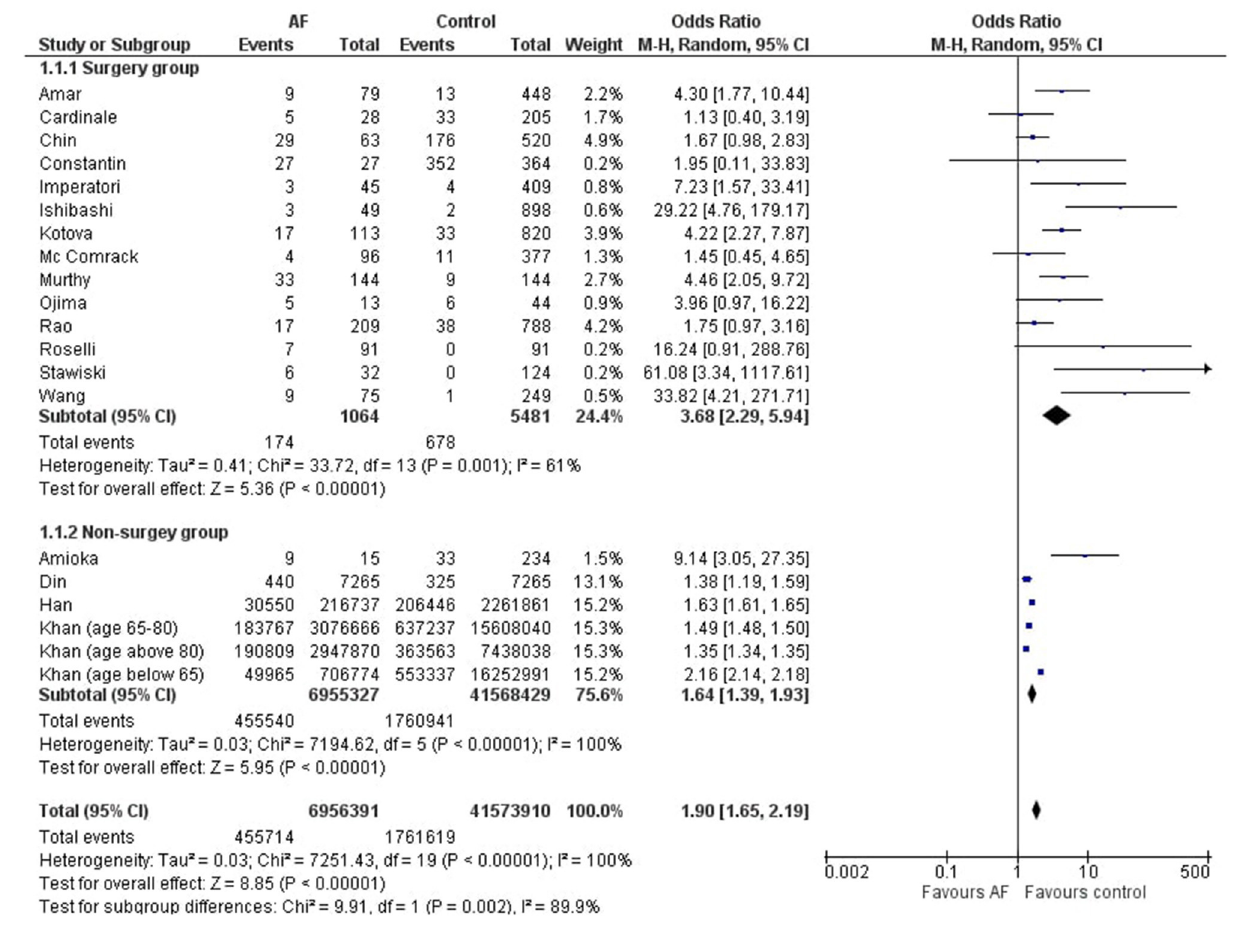
FIGURE 3 | Forest plot showing effect size of mortality outcome of atrial fibrillation in different types of cancer and also its overall